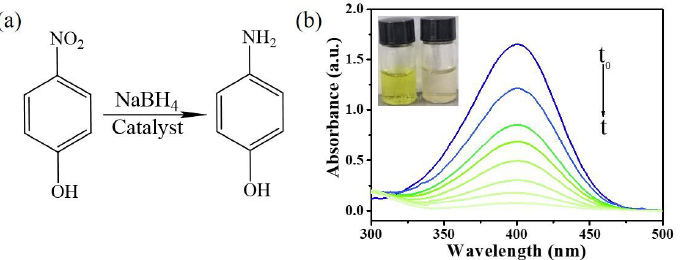
Figure 2. Catalytic reaction of 4-NP to 4-AP. ( a ) The catalytic reaction equation. ( b ) Time-dependent UV–Vis spectra showing gradual reduction of 4-NP over the sample Ag/p-ZnO collected in the cuvette under natural light, with digital photos of color changes before (left) and after (right) the reaction inserted.